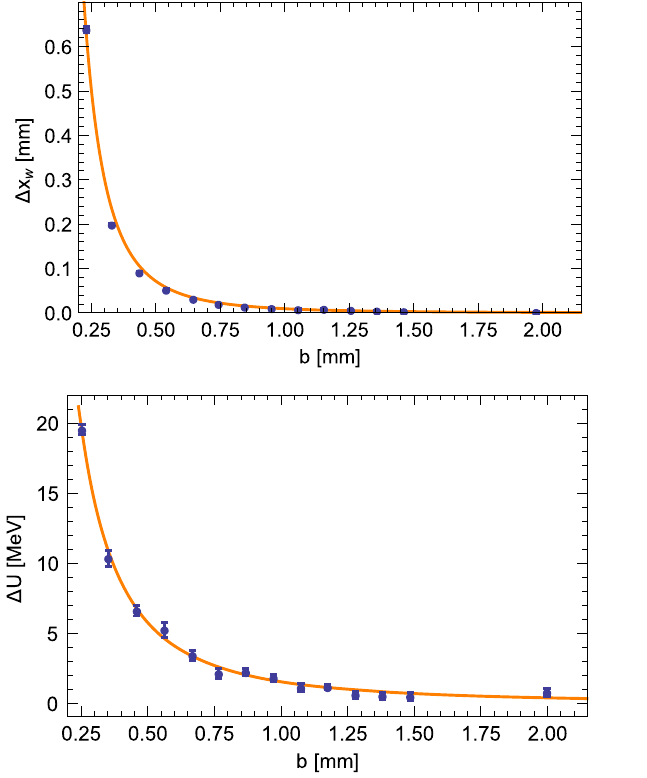
FIG. 6. Single south jaw measurements of transverse (top) and longitudinal (bottom) wakefield kicks. The symbols give the data points, with their b values shifted by − 58 μ m (top) and − 73 μ m (bottom); the curves give the analytical